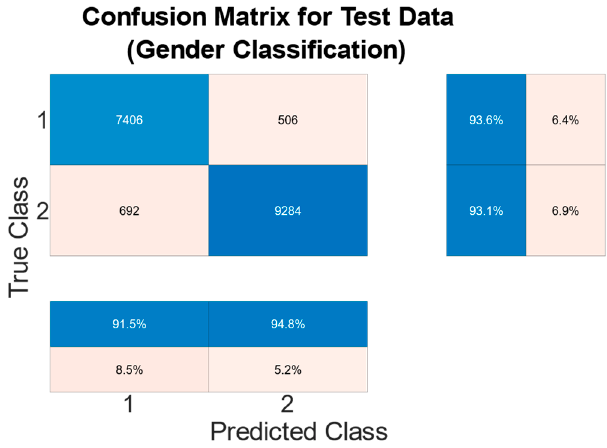
Figure 11. Gender Classification using Final CNN Model.